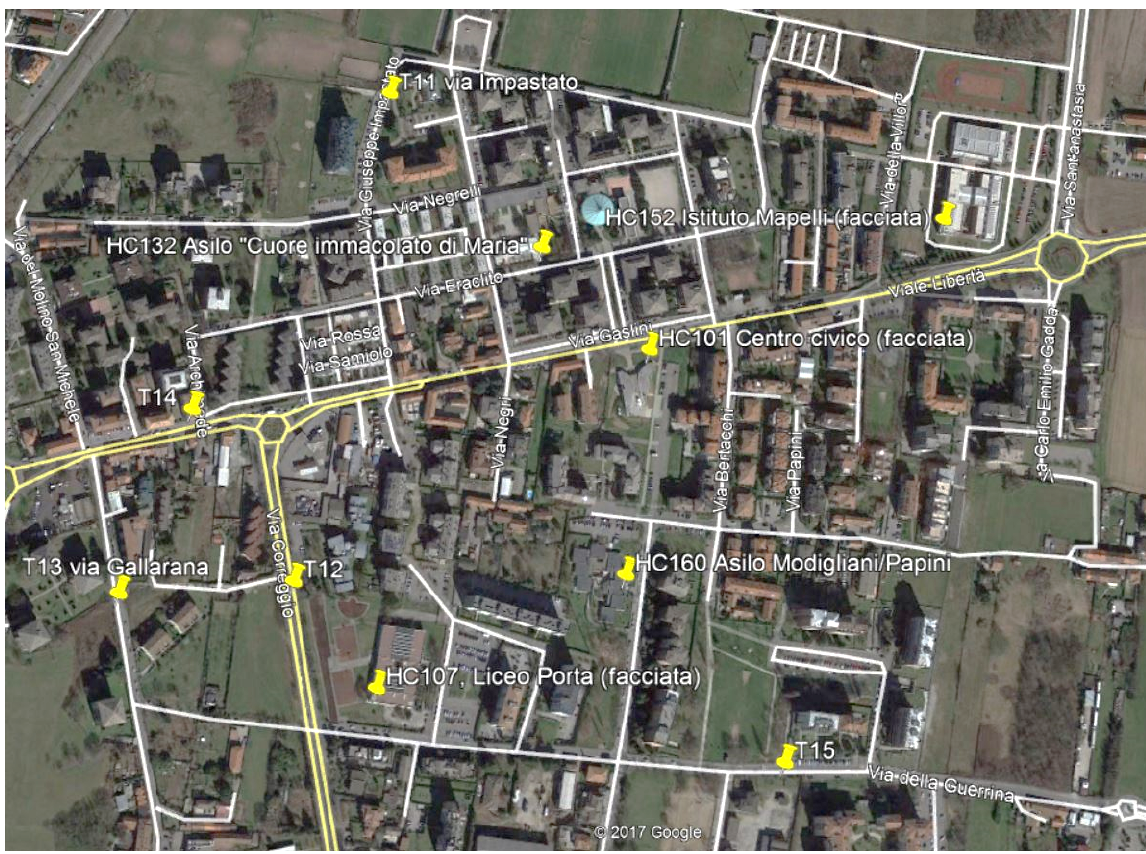
Figure 6: Selected noise monitoring